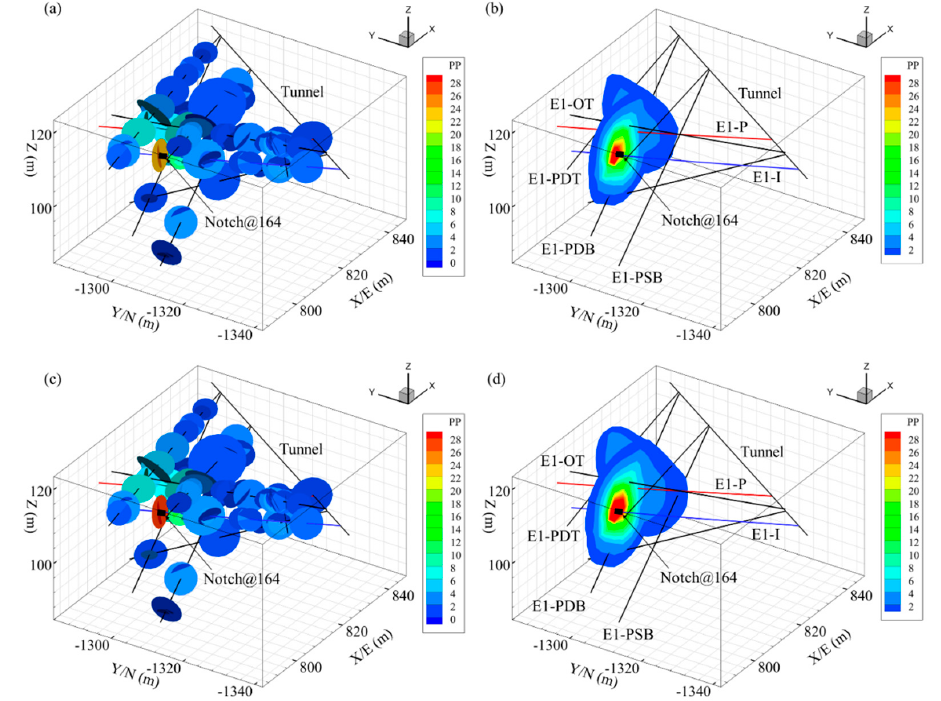
Figure 11. Fracture and matrix pressure at different times: ( a , b ) show the fracture and matrix pressure at time T22:36, respectively; ( c , d ) show the fractures and matrix pressure at time T22:43. The slices locations in ( b , d ) are X = 823 m and Y = − 1296.5 m, respectively. Unit: MPa. As injection continues, simulation shows that fracture I-164a/b starts to open and propagate (non-planar) at approximately T22:44 (Figure 12a,b). The natural fractures (e.g.,